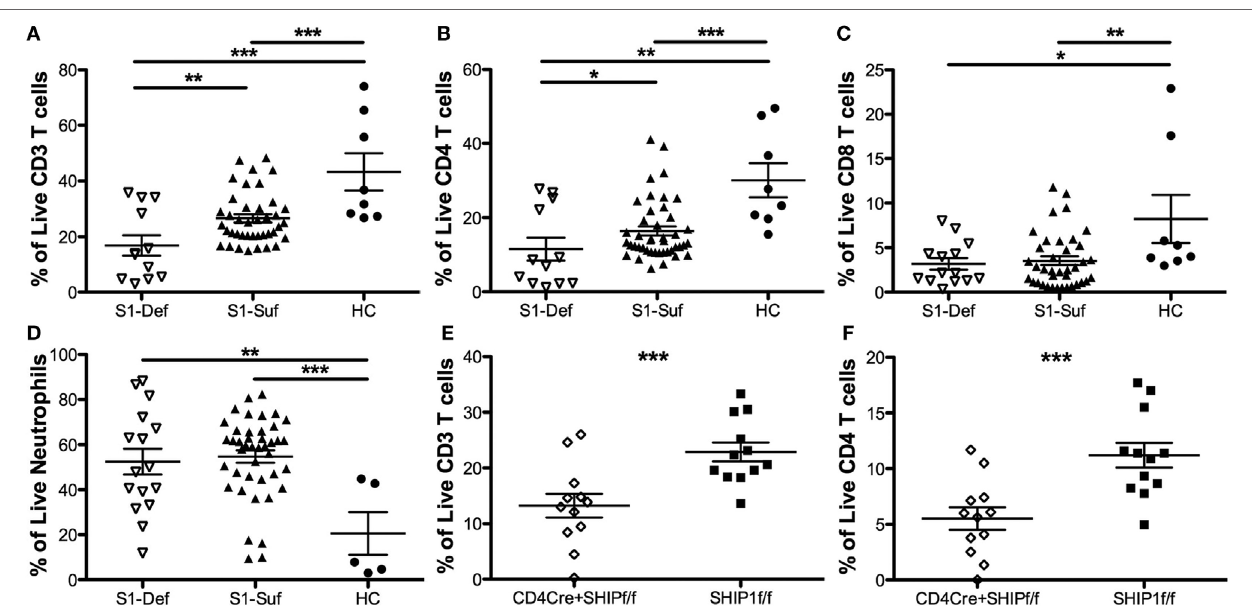
FigUre 6 | SHIP1-deficient inflammatory bowel disease (IBD) patients have significantly reduced CD4 T cell numbers relative to other IBD patients and healthy controls, similar to mice with a conditional mutation of SHIP1 in T lymphocytes. Frequency of CD3 + T cells (a) , CD4 + T cells (B) , CD8 T cells (c) , and neutrophils (D) were compared among SHIP1-deficient (S1-Def), SHIP1-sufficient (S1-Suf), and healthy control (HC). Leukocytes cultured ex vivo for 1 h in complete media prior to intracellular flow cytometry staining for SHIP1. (Data points were pooled from multiple independent analyses, one-tailed t -test, * P < 0.05, *** P < 0.001, **** P < 0.0001. Duplicate samples were analyzed for each subject, total number of independent subjects analyzed: S1-Def = 6, S1-Suf = 21, HC = 4.) (e) Frequency of live and CD3 + T cells (e) and CD4 + T cells (F) in leukocytes of CD4CreSHIP flox/flox and SHIP flox/flox control mice (one-tailed t -test *** P < 0.001, n =